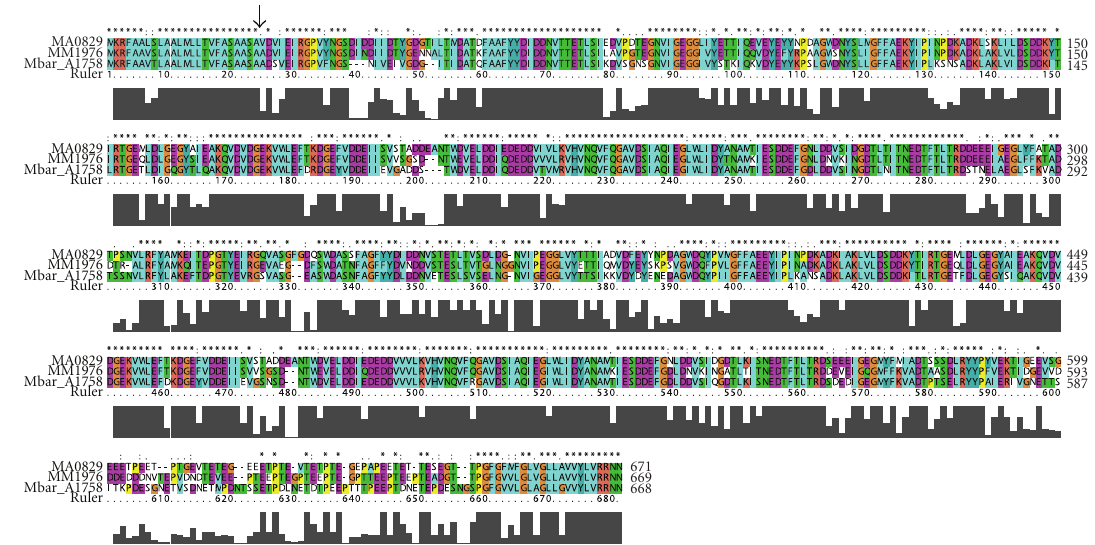
Figure 6: Primary amino acid alignment of the three major Methanosarcina S-layer proteins, Mbar A1758, MA0829, and MM1976. Identity of the sequences is indicated by asterisks. The experimentally determined mature N-terminus for Mbar A1758 (Section 3) is indicated by the